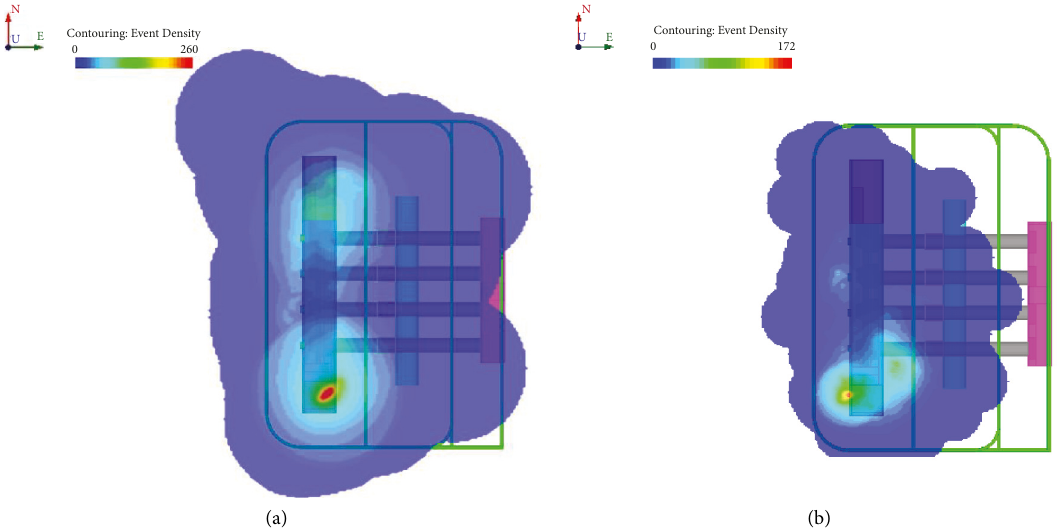
Figure 15: Density cloud map of microseismic events in the main powerhouse. (a) In 2018. (b) In